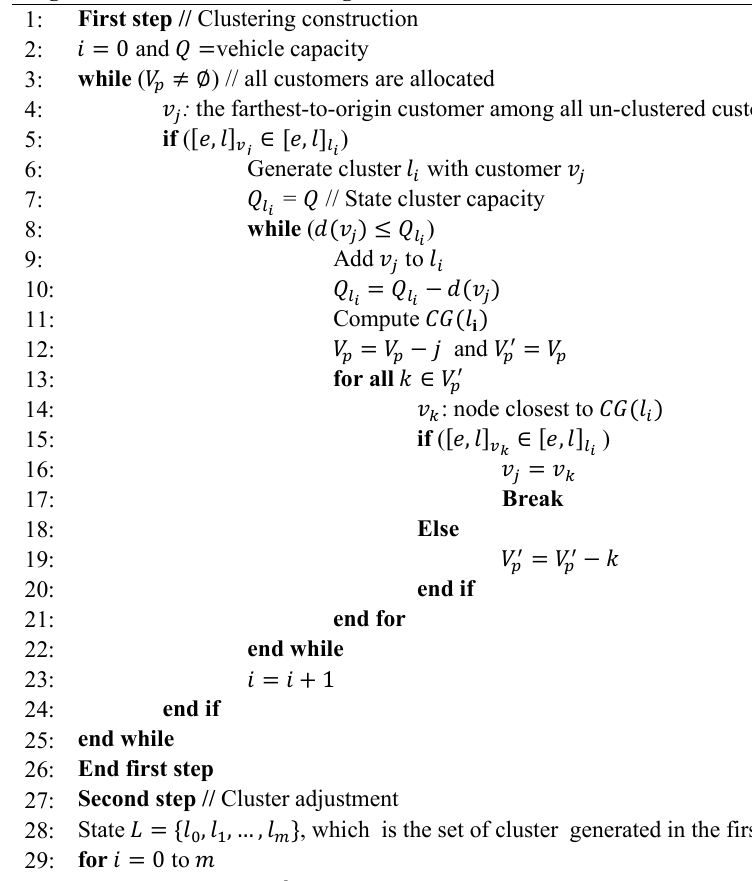
Algorithm 1. Centroid-Based